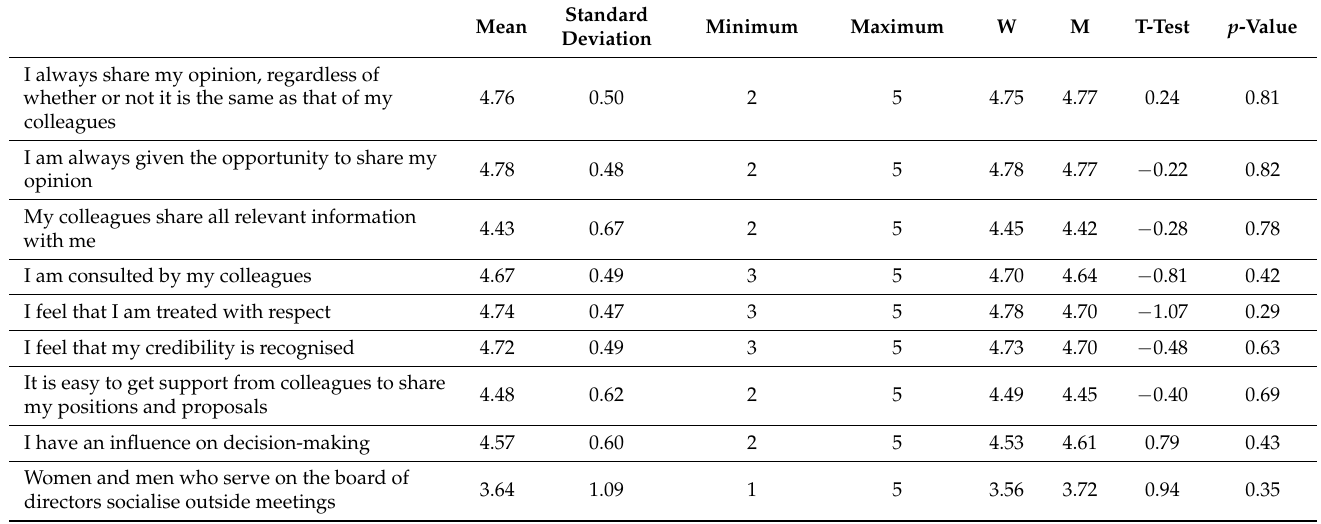
Table A3. Descriptive statistics and mean comparison between women and men who responded to P22—Please indicate, on a scale from 1 = Completely Disagree to 5 = Completely Agree, to what extent you agree with the following statements regarding your interaction with the other members of the board of directors.